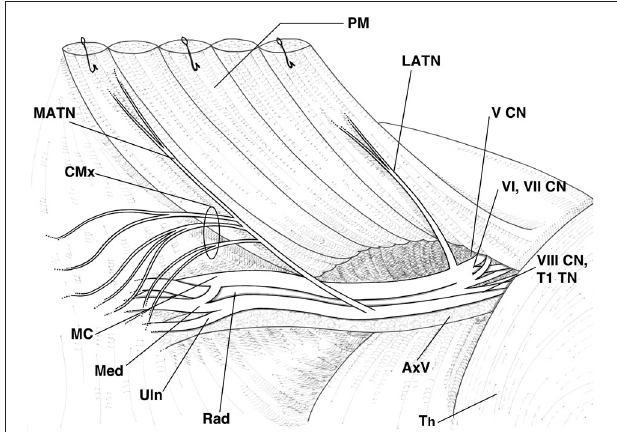
FIGURE 1 | Schematic representation of the right rat brachial plexus highlighting the relations of the lateral and medial anterior thoracic nerves. PM, pectoral muscles, reflected; MATN, medial anterior thoracic nerve; CMx, branches of the MATN to the cutaneous maximus muscle; LATN, lateral anterior thoracic nerve; V CN, fifth cervical nerve; VI, VII CN, sixth and seventh cervical nerves; VIII CN, TI TN, eighth cervical nerve and first thoracic nerve; Th, thorax; AxV, axillary vessels; Rad, radial nerve; Uln, ulnar nerve; Med, median nerve; MC, muscolocutaneous